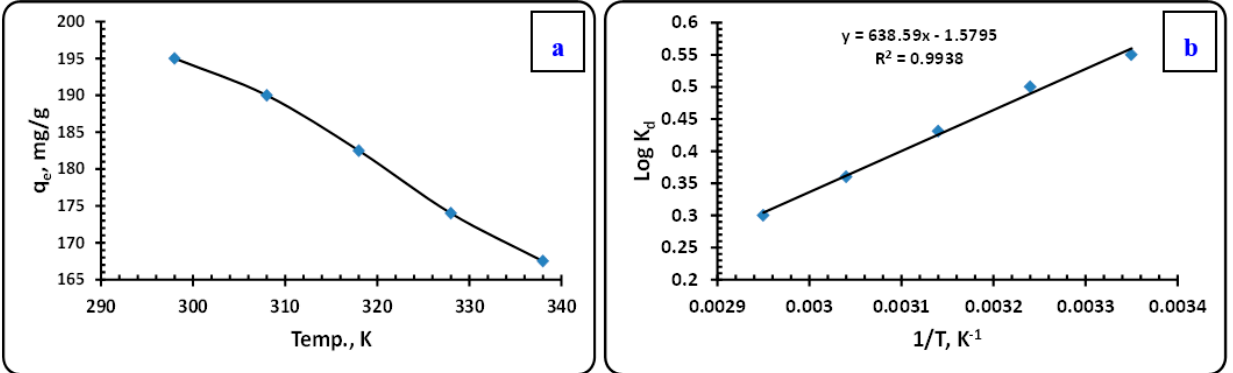
Figure 10. ( a ) The effect of temperature on zirconium ions uptake by PPVP. ( b ) The effect of temperature on the partition coefficient of zirconium ions using PPVP.